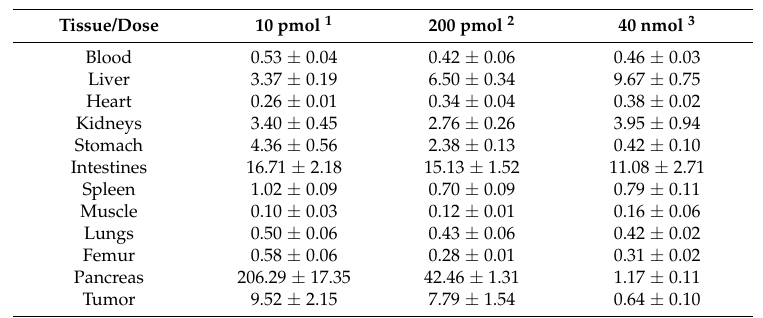
Table 1. [ 67 Ga]NeoBOMB1 biodistribution data, as % ID/g mean ± sd, n = 4; at 4 h pi in T-47D Xenograft-Bearing SCID Mice; results in 3 different NeoBOMB1 doses are included in each column, with 40 nmol administered for in vivo GRPR-blockade.